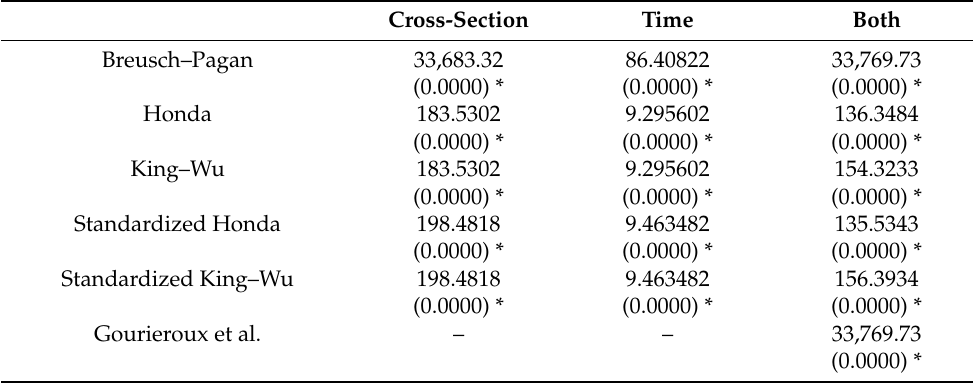
Table 2. LM test—RE